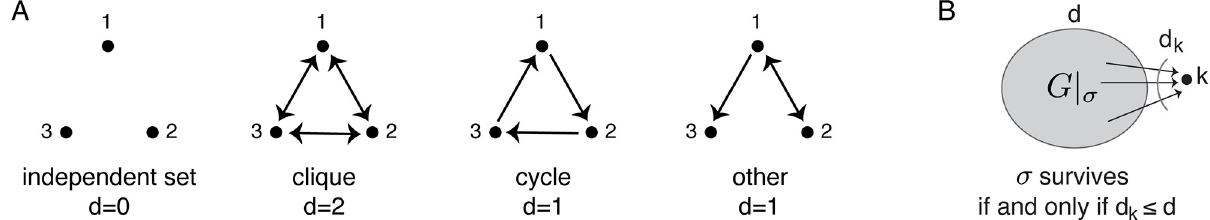
Fig 2. Uniform in-degree graphs. (A) All n = 3 graphs with uniform in-degree. (B) Cartoon showing survival rule for an arbitrary subgraph with uniform in-degree d .